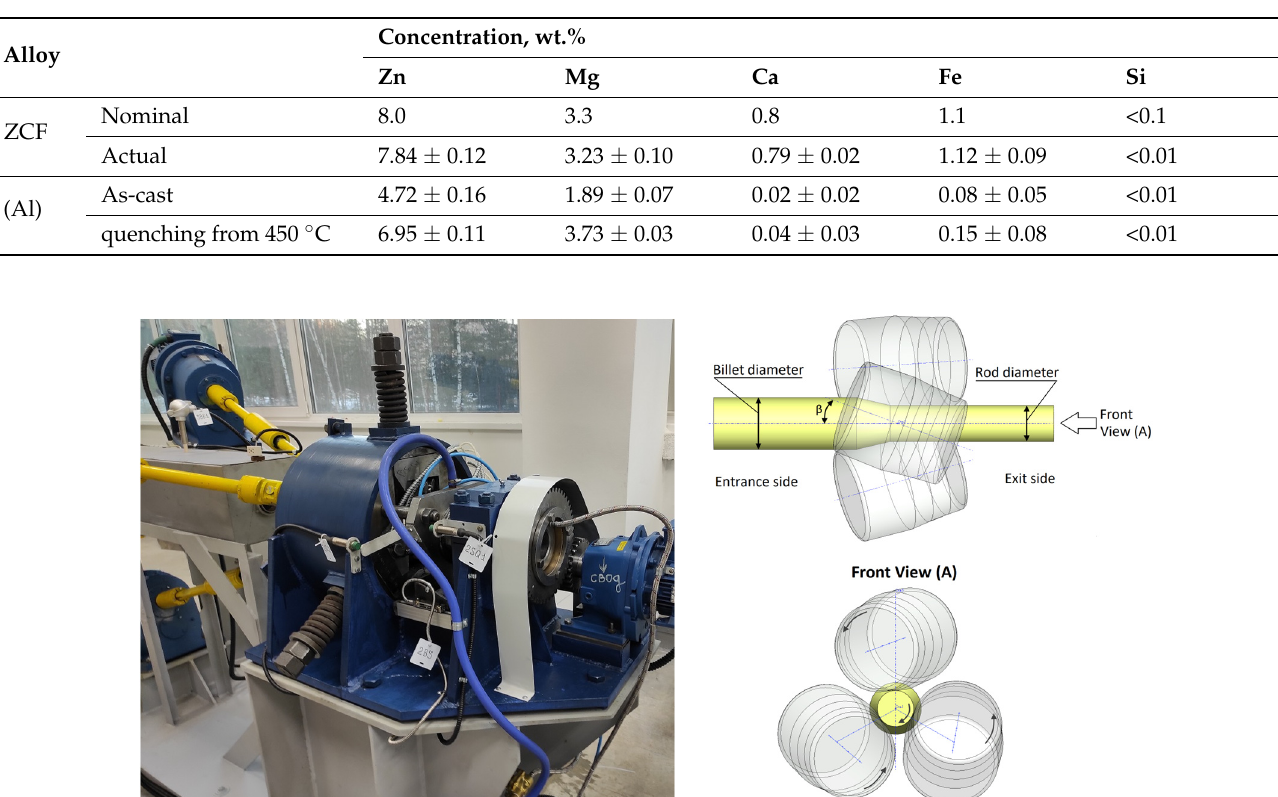
Table 1. Chemical composition of the experimental aluminum alloy and aluminum solid solution (Al).